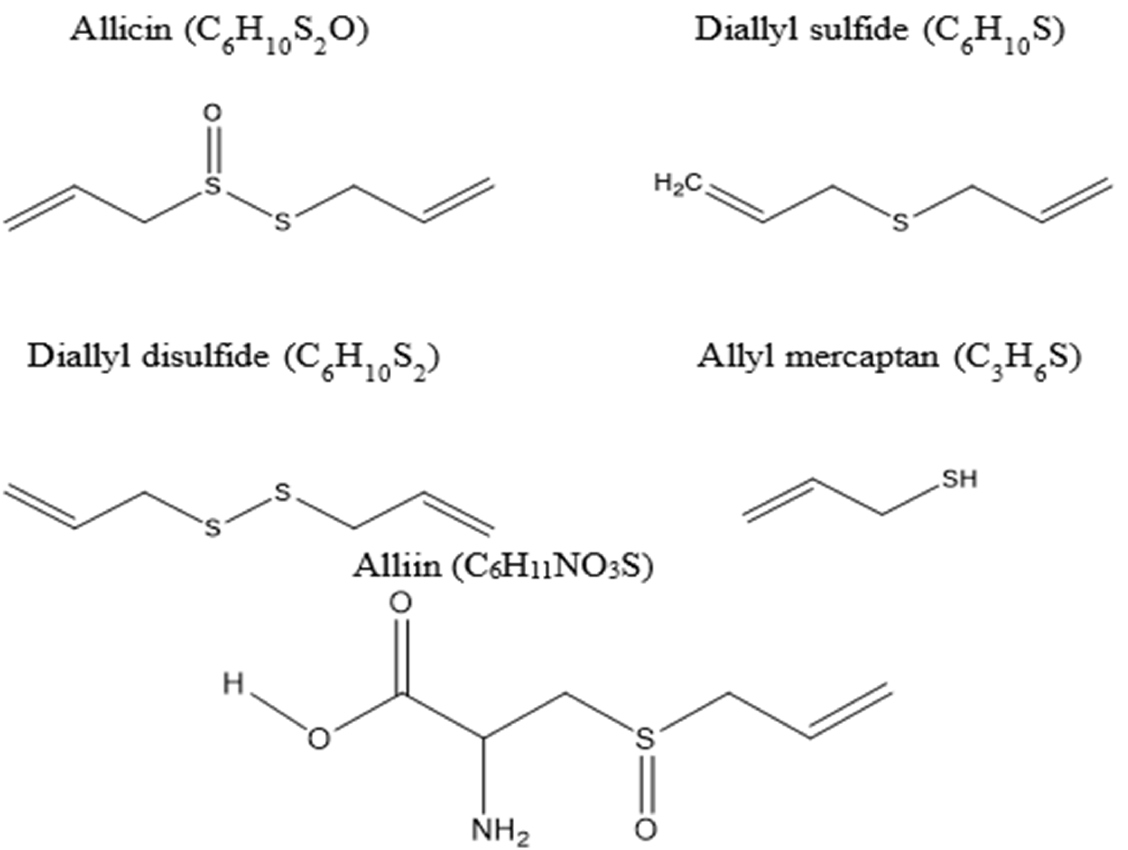
Figure 3. Chemical structures of allicin (C 6 H 10 S 2 O), diallyl sulphide (C 6 H 10 S), diallyl disulphide (C 6 H 10 S 2 ), allyl mercaptan (C 3 H 6 S), and alliin (C 6 H 11 NO 3 S).